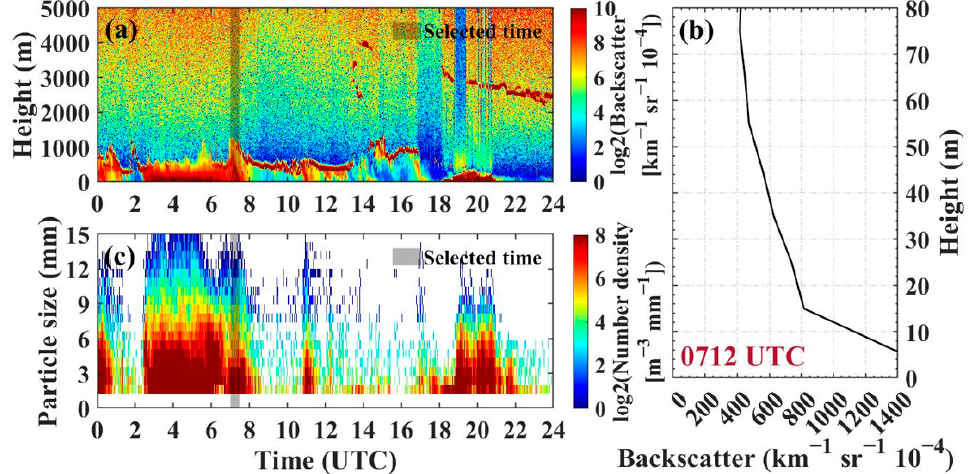
Figure 7. ( a , c ) represent the backscattered echo map of ceilometer and the average particle number density of parsivel 2 on 6 December 2016, respectively. ( b ) Backscatter profile of ceilometer at 0712 UTC.